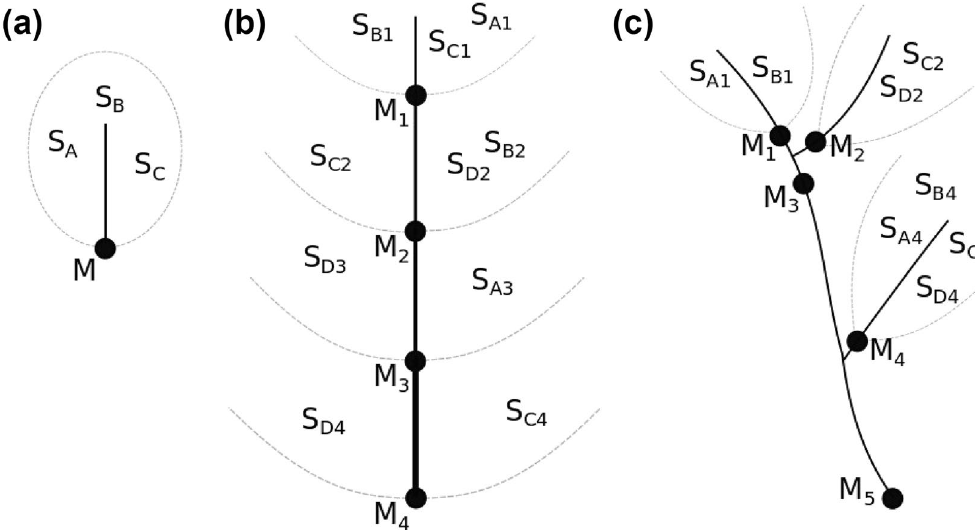
Figure 1. Example experimental designs demonstrating how MixSIAR apportions sources in hierarchical river networks. In all designs, rivers flow downward, filled circles represent nodes at which sediment mixture (Mix = M) samples could be collected, and dashed grey lines delineate watersheds (S) denoted by subscript numbers, and subscript letters indicate unique sources. ( A ) Simple watershed with three sources, S A-C , and one mixture location at the outflow, M. ( B ) Longitudinal system with four sources, S A-D , and multiple mixture locations at the outlet of each nested subwatershed, M 1–4 . ( C ) Distributed system with mixtures at the outflow of each of three subwatersheds, M 5 . (note: not all sources are present in all